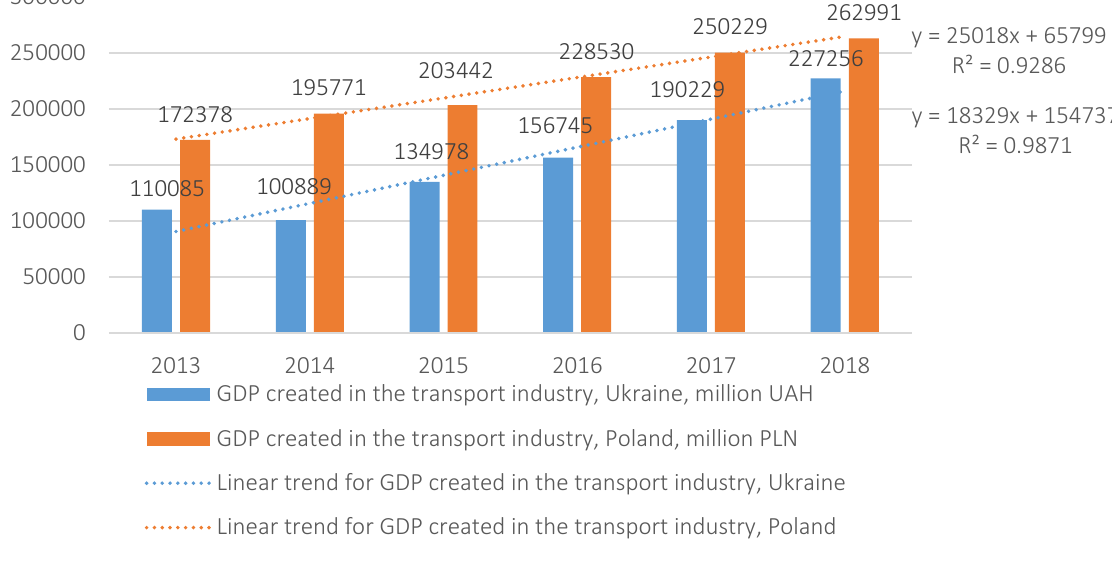
GDP created in the transport industry, Ukraine, million UAH GDP created in the transport industry, Poland, million PLN Linear trend for GDP created in the transport industry, Ukraine Linear trend for GDP created in the transport industry, Figure 2. The dynamics of GDP created in the transport industry in 2013–2018 in Ukraine (million UAH) and Poland (million PLN)